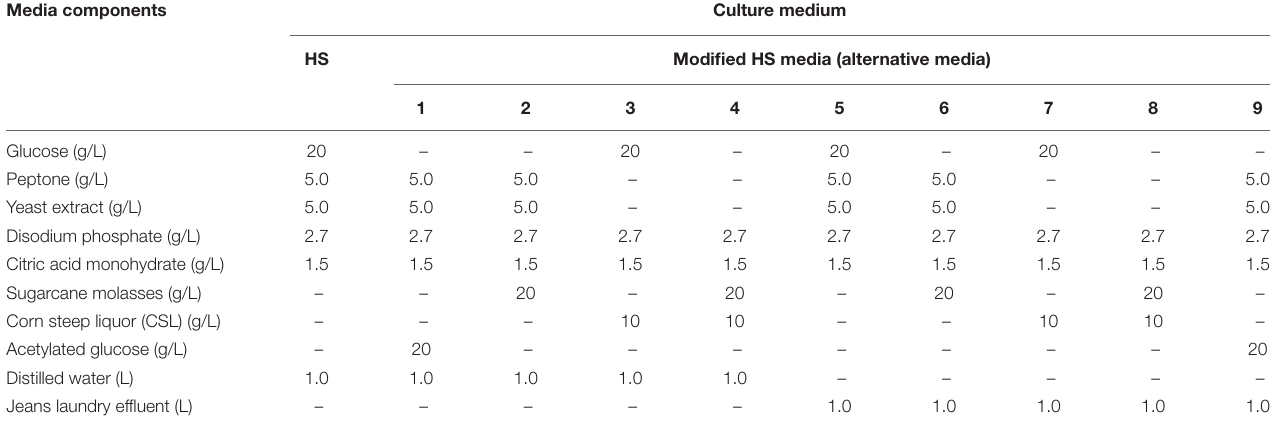
TABLE 1 | Composition of media used for production of